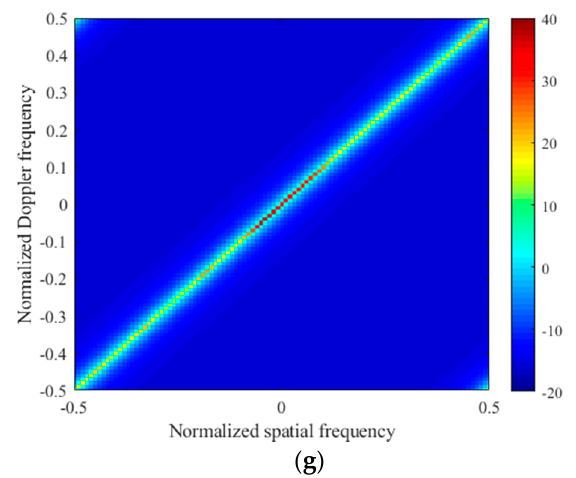
Figure 3. Clutter Capon spectrum with the absence of nonideal factors. ( a ) Ideal CNCM; ( b ) M-OMP; ( c ) M-FOCUSS; ( d ) M-IAA; ( e ) M-SBL; ( f ) M-FCSBL; ( g ) ASDSPL.